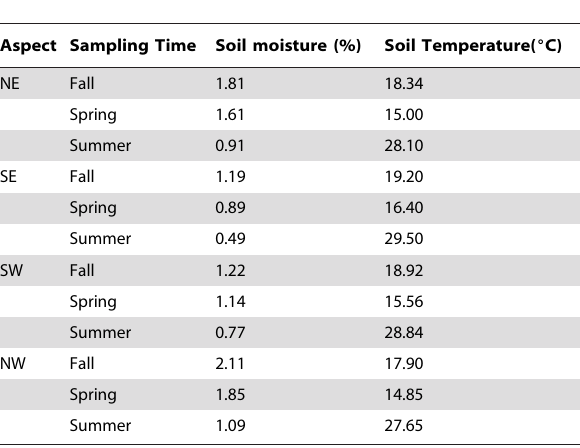
Table 1. Means of microclimate factors of Nitraria tangutorum nebkhas.